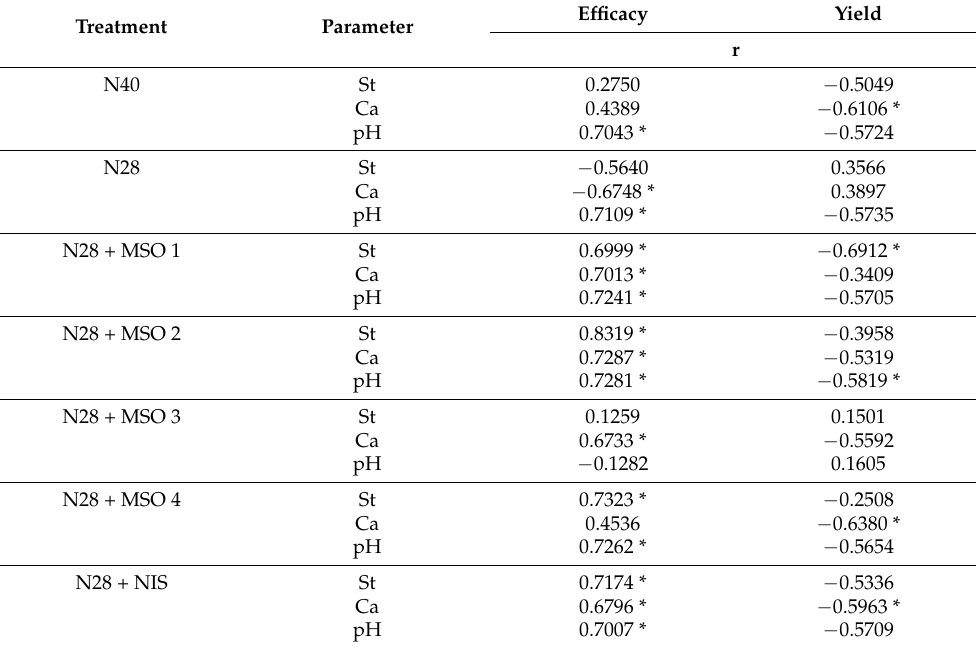
St—surface tension; Ca—contact angle; r—correlation coefficient; * the indicated correlation coefficients are significant at p ≤